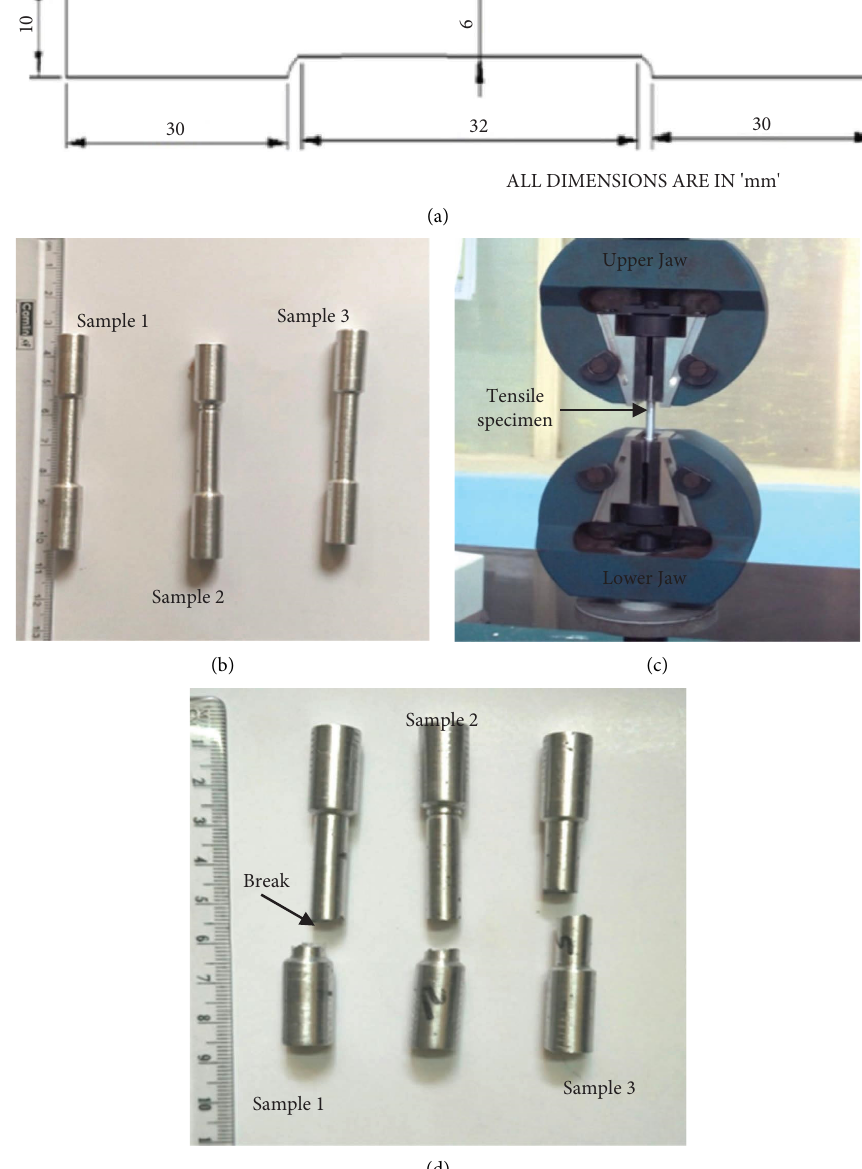
Figure 2: (a) Tensile sample dimension; (b) prepared cast samples for tensile testing; (c) tensile testing in the UTM machine; (d) specimen after tensile